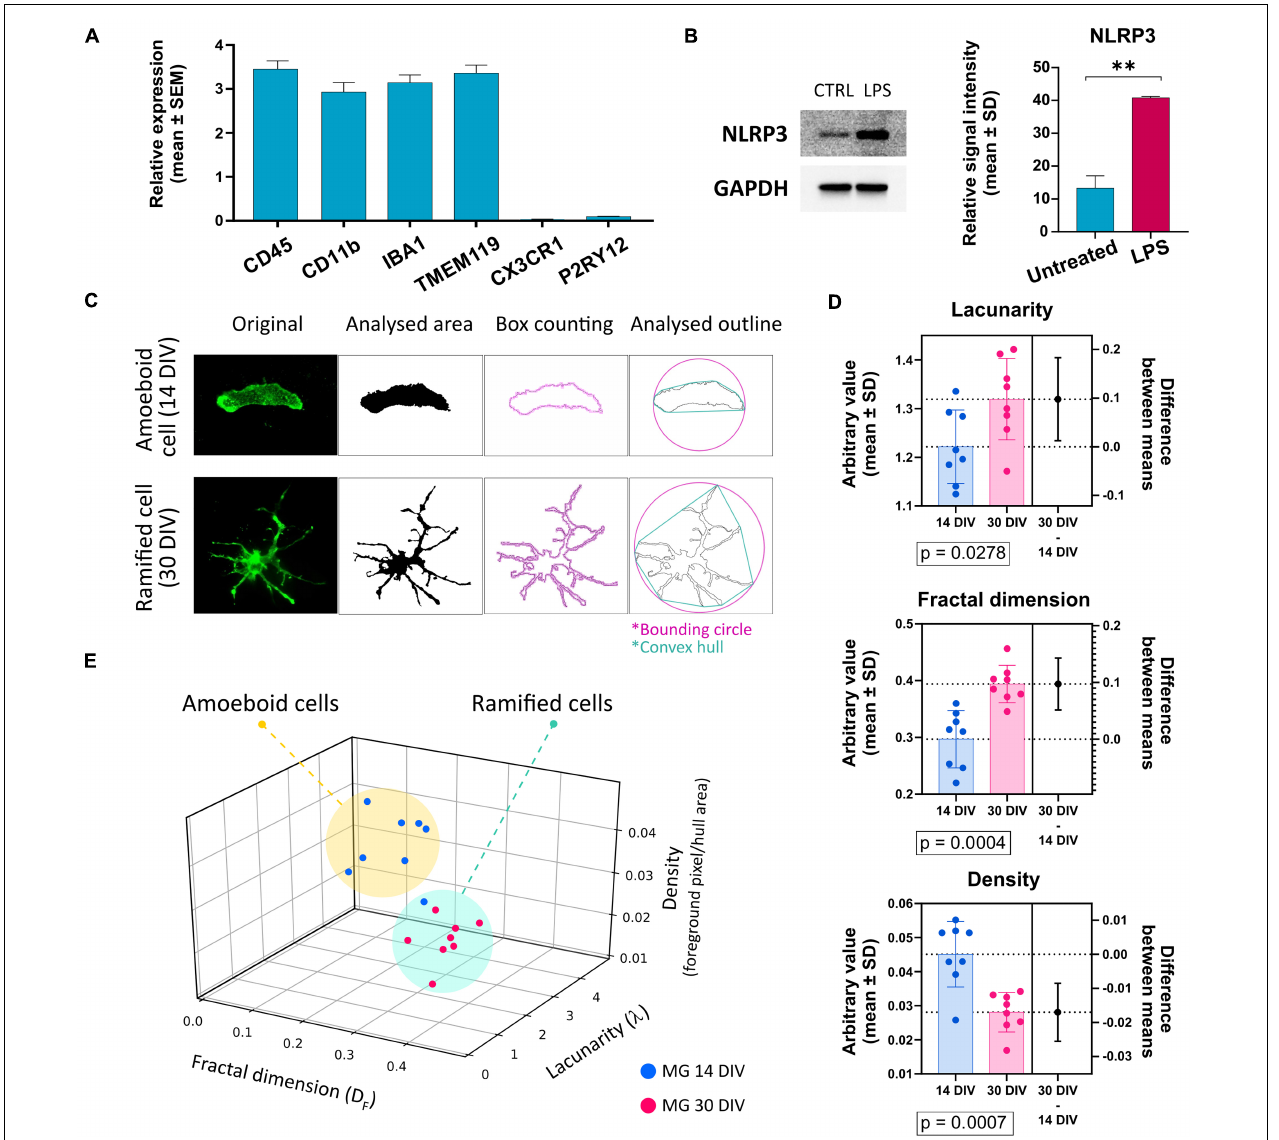
FIGURE 4 | (A) Detection of the expression of microglia-specific markers via RT-qPCR. Expression values were normalized to GAPDH and calculated as a relative expression value related to the total human cortical mRNA reference sample. Most of the evaluated markers were detected in high amounts, except for CX3CR1 and P2RY12. Error bars represent the mean ± SEM of three measurements performed as technical triplicate. (B) Verification of microglia-like cells’ capacity to become activated upon the treatment with 1 µ g/ml of LPS. Activation was estimated via the detection of NLRP3 protein’s upregulation via Western blot. Western blot analysis is representative of three independent experiments. Error bars represent the mean ± SD of three measurements. ∗∗ p < 0.01. (C) Example of the image analysis using FracLac box-counting method for microglia ramification assessment. Original immunocytochemistry pictures were subjected to uniform FIJI protocols, binary picture, and cell outline preparation. Box counting (pink squares along the cell outline), convex hull (turquoise polygon), and bounding circle (pink) were used by FracLac for subsequent calculations. (D) Comparison of the individual variables between cells from early and late co-cultures. n = 16. (E) Plotting the values on a 3D plot based on the relationship between the three variables (fractal dimension, lacunarity, density) distributes the individual data points (representing individual microglia cells) into two populations marked as amoeboid cells and ramified cells. The two groups’ distribution correlates with the time-lengths of microglia-neuron co-cultivations. Error bars represent the mean ± SD. Statistical analysis was performed with an unpaired Student’s t -test. p -values are indicated below the respective